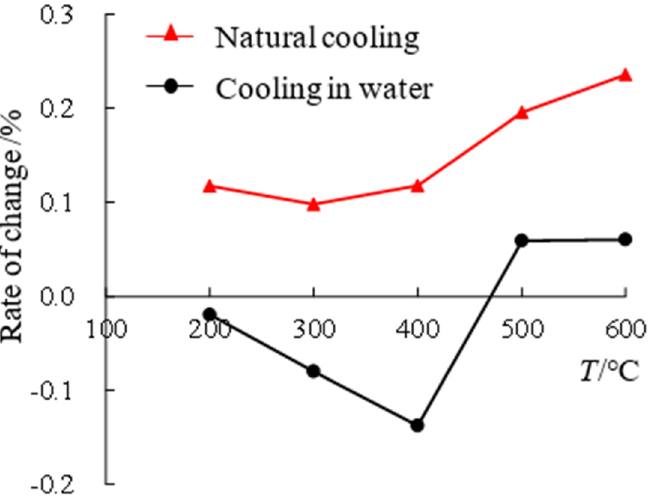
Figure 4. Mass change after different cooling methods.